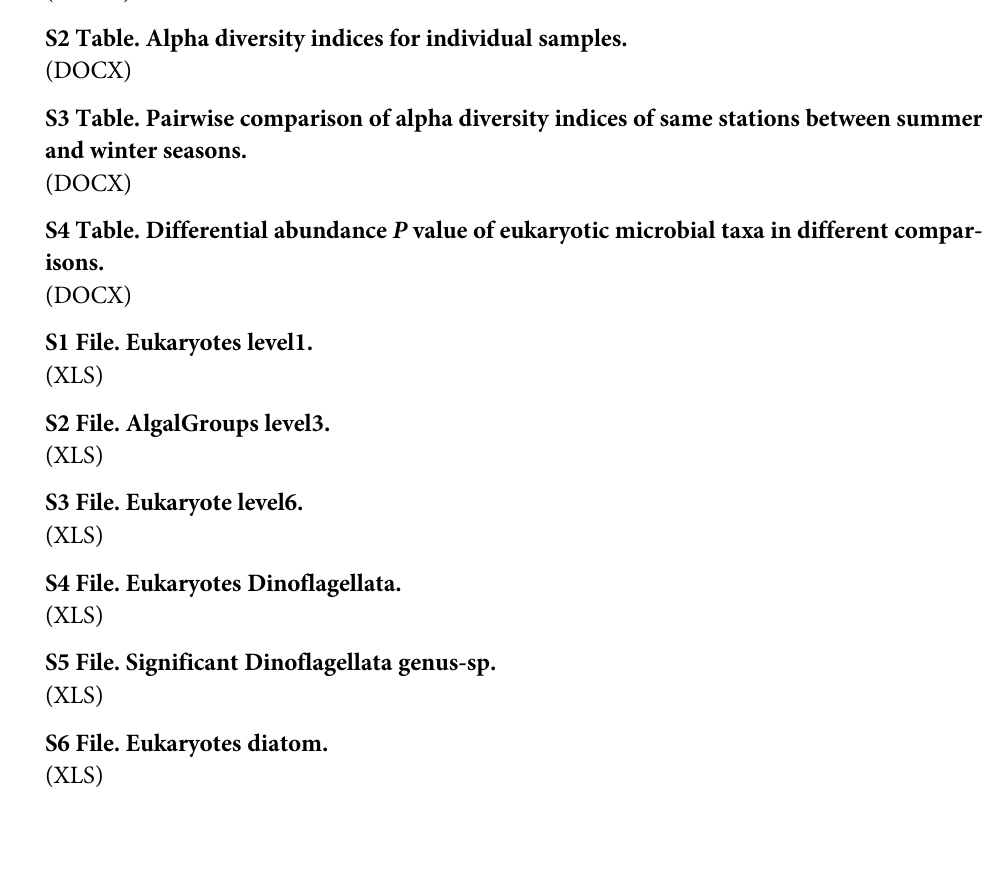
S7 Fig. Relative abundance of Dinoflagellate species across samples collected from differ- ent sampling stations of Kuwait Bay. ‘Others’ include genera with an abundance of < 0.05%. S8 Fig. Relative abundance of diatom genera across all samples collected from different sampling stations of Kuwait Bay. ‘Others’ include genera with an abundance of < 0.1%. S9 Fig. Relative abundance of diatom species across all samples collected from different sampling stations of Kuwait Bay. ‘Others’ include genera with an abundance of < 0.1%. S1 Table. Summary of data after various filtering steps. S2 Table. Alpha diversity indices for individual samples. S3 Table. Pairwise comparison of alpha diversity indices of same stations between summer and winter seasons. S4 Table. Differential abundance P value of eukaryotic microbial taxa in different compar-